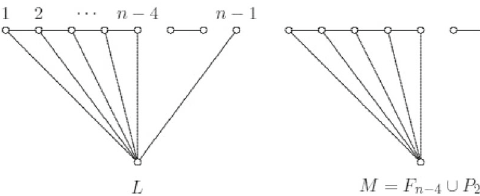
Fig. 6 The graphs L and M after applying Theorem 2.5 to G (cid:2)(cid:2)